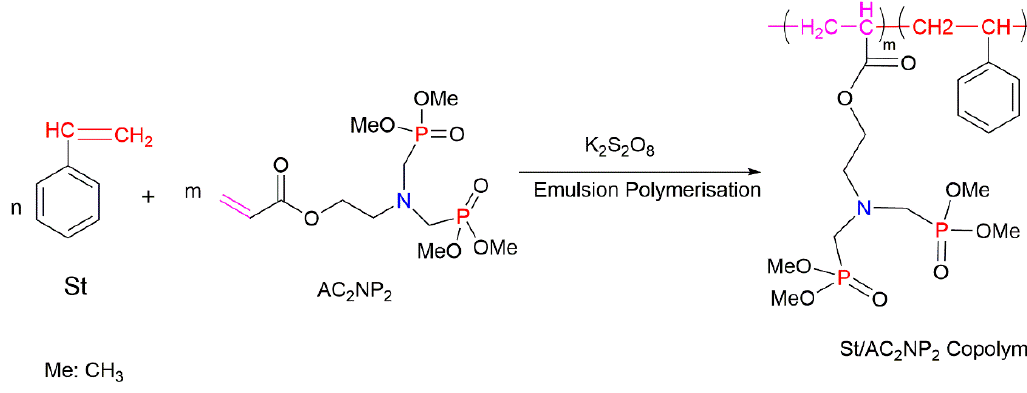
Figure 26. Emulsion polymerisation of St with AC 2 NP 2 [107].